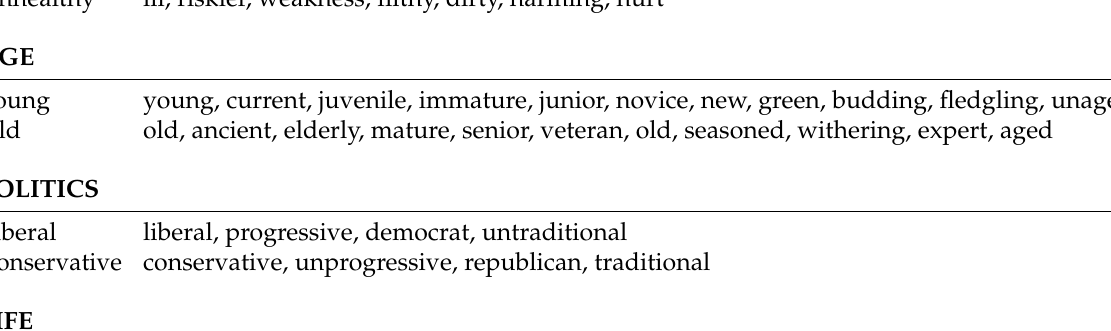
Table 1: Examples of juxtaposing terms for semantic directions HEALTH